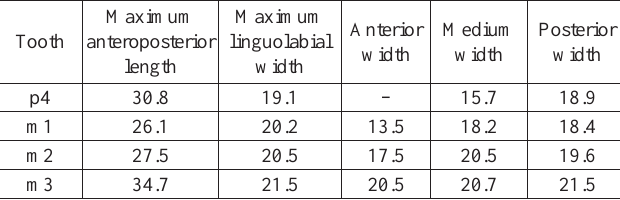
Table 2. Dental measurements (in mm) of MHNC-MS-001. As the